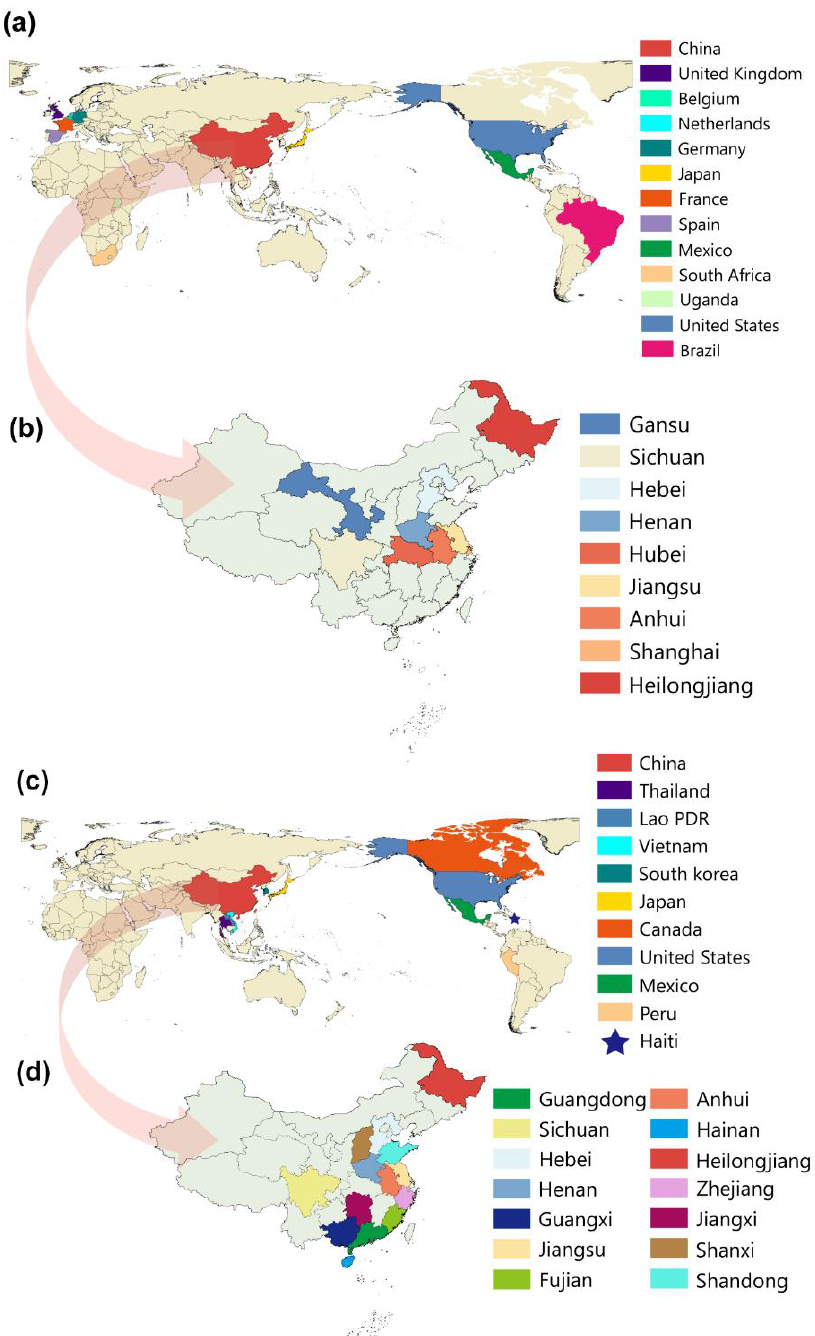
Figure 2. Geographical distribution of TGEV and PDCoV around the world and in China. ( a ). Different colors characterize the distribution of TGEV in different countries. ( b ). Distribution of TGEV in China, different provinces were indicated by different colors. ( c ). Different colors characterize the distribution of PDCoV in different countries. ( d ). Distribution of PDCoV in China, different provinces were indicated by different colors.